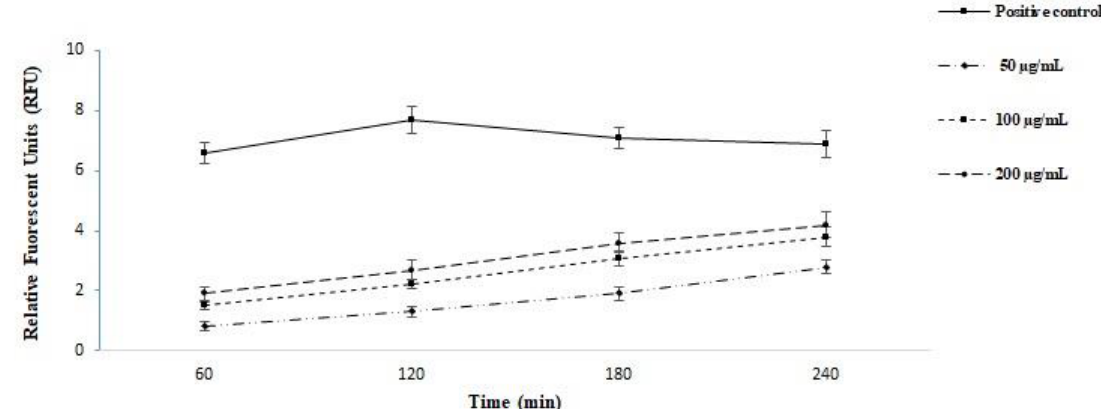
Figure 3. The plasma membrane permeability of the L. major promastigotes treated with Z. spina-christi methanolic extract. The findings of relative fluorescent units confirmed that the promastigotes treated with Z. spina-christi methanolic extract, particularly at the concentration of 200 μg/mL , change the permeability of the plasma membrane by Sytox Green.